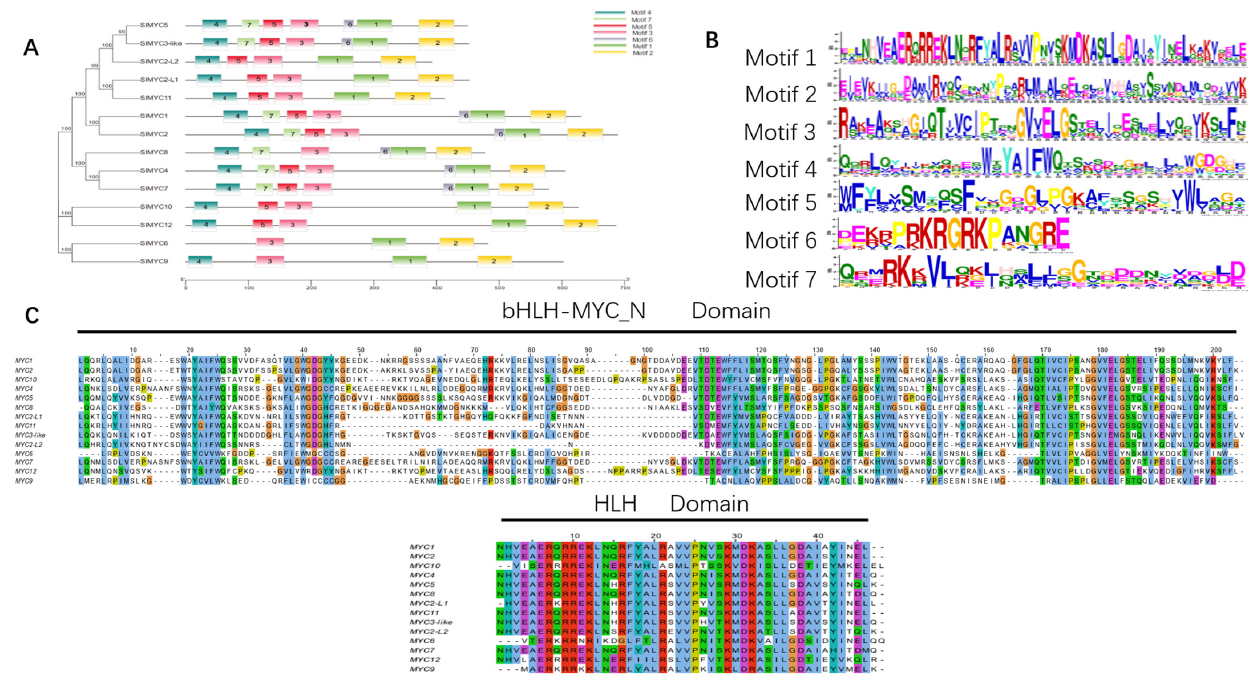
Figure 3. Phylogenetic and conserved motifs of MYC proteins in tomato. ( A ) Phylogenetic and conserved motif distribution of 14 tomato MYCs. The tree is rooted. ( B ) Logo sequences for 14 SlMYC conserved motifs. ( C ) Multiple alignments of MYC and two conserved domains (bHLH_MYC_N and bHLH) of tomato MYC protein. The conservative amino acids were used different colours.